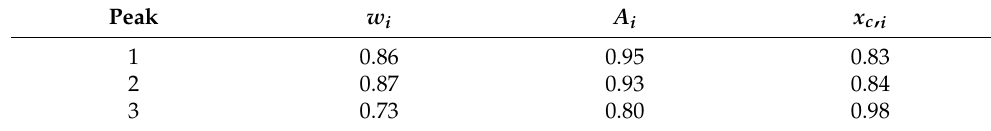
Figure 5. Linear relationship between w i , A i , x c , i and the amount of substrate added. Red dots represent OLR > 5 kg TVS/L. They were not taken into account in calculating R 2 . Table 3. Determined R 2 -values for w i , A i , x c , i in relation to the amount of substrate